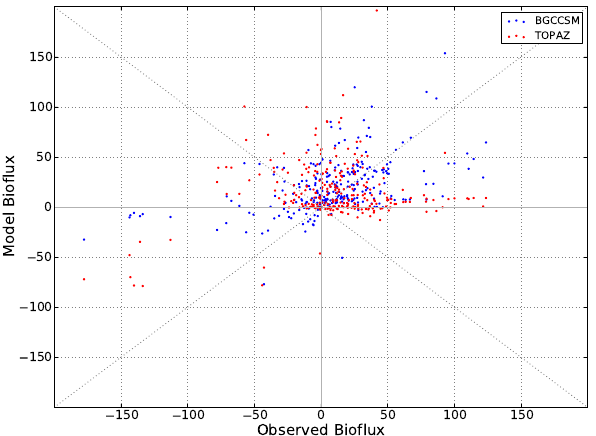
Figure 12. Scatterplots of model versus observed O 2 bioflux (mmolm − 2 d − 1 ) for the observational sampling sites shown in Fig. 1. All observations that fall on a specific grid cell at a specific day of the year are averaged to one value. Models are subsampled at the location and day of the year of the